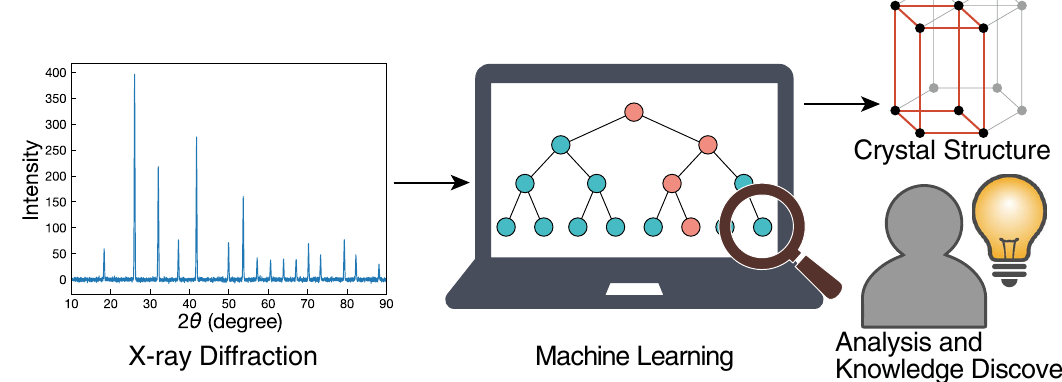
Figure 1. Overview of our ML methodology for crystal system and space group classification based on powder XRD patterns. One may also obtain data-driven insight by analysing the interpretable ML